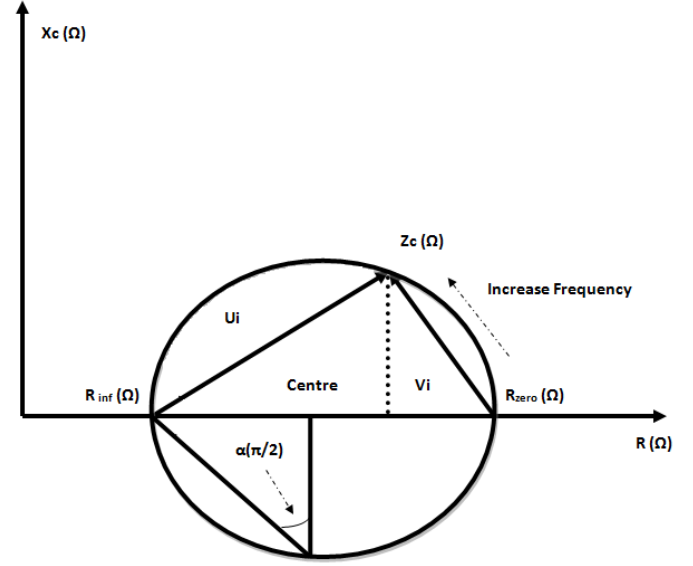
Figure 2. Cole-Cole module plot and Cole module